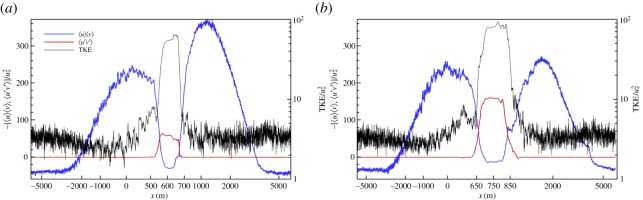
Normalized momentum fluxes, 〈u〉 〈v〉 and 〈u′v′〉 in (6.5), and turbulent kinetic energy (TKE) near the surface during the frontal arrest phase for TTW-induced frontogenesis of a dense SBL filament: (a) t=4.2 h after the end of the initialization (i.e. the same time as in figure 9) and (b) t=6.7 h. The abscissa is a stretched x-coordinate to show both the near and far fields of the filament centred at the place of maximum ∂x〈 v〉. The jitter in the curves is sampling error associated with the finite domain in y [80].